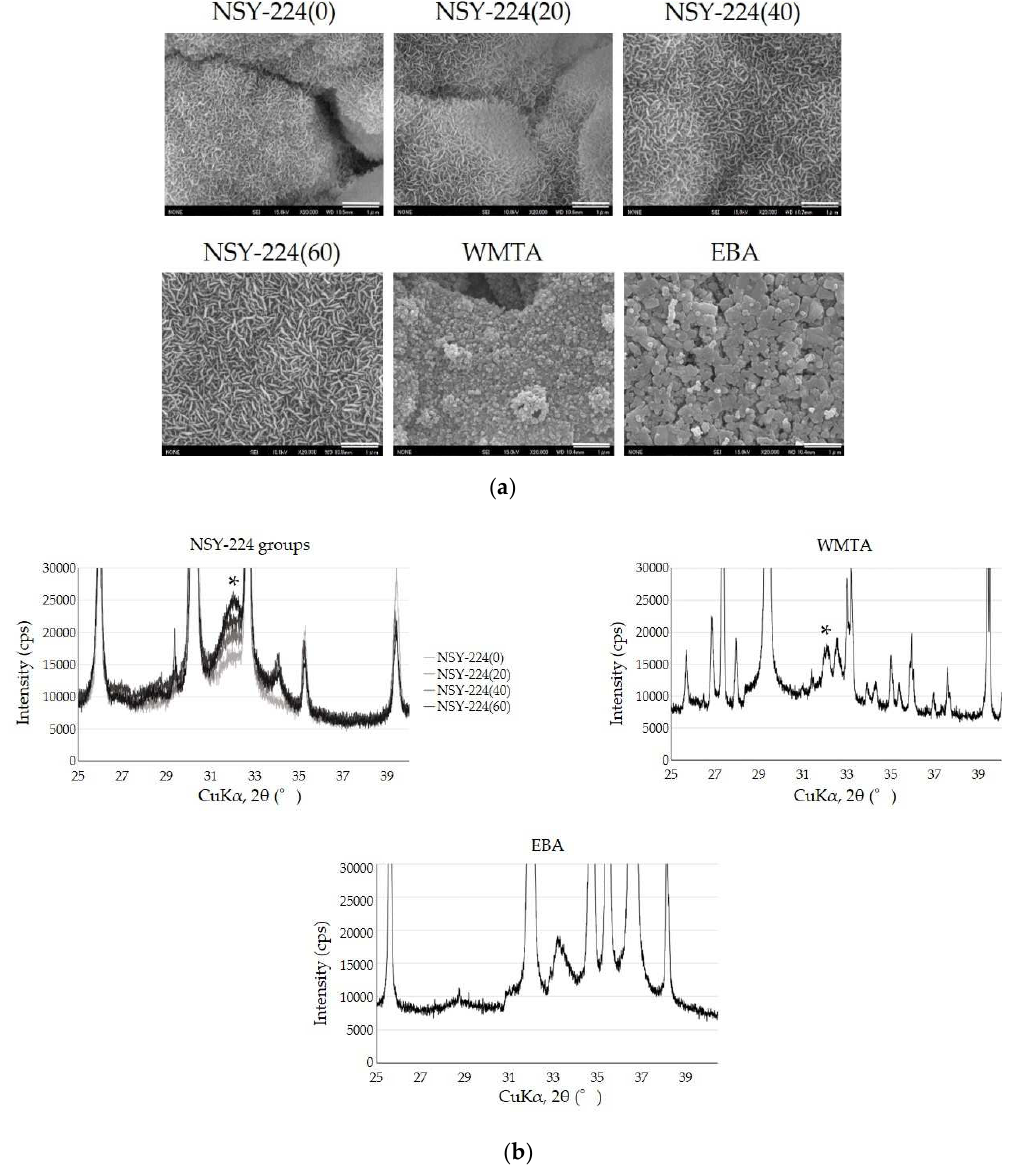
Figure 1. Formation of apatite and crystal analysis. ( a ) FE-SEM images of cement surface. Scale bars, 1 µm. ( b ) Crystal analysis using X-ray diffraction. * in the figure shows the position of the apatite peak.